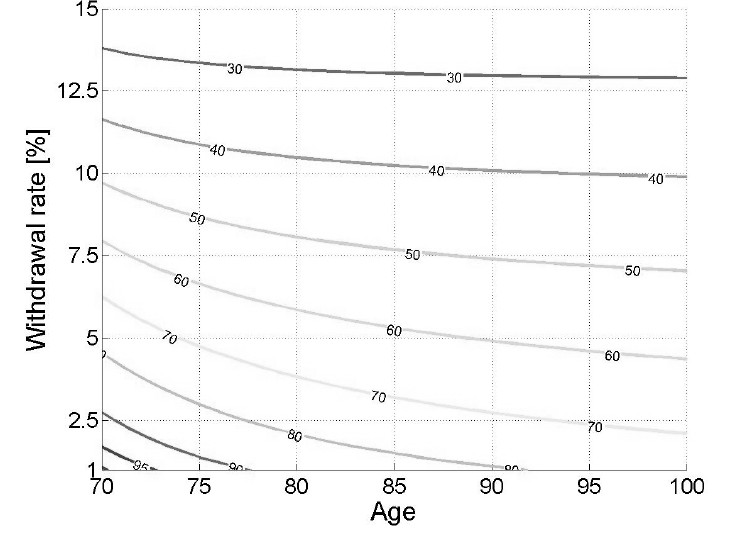
FIGURE 3: Financial survival probability for the high-risk portfolio Source: